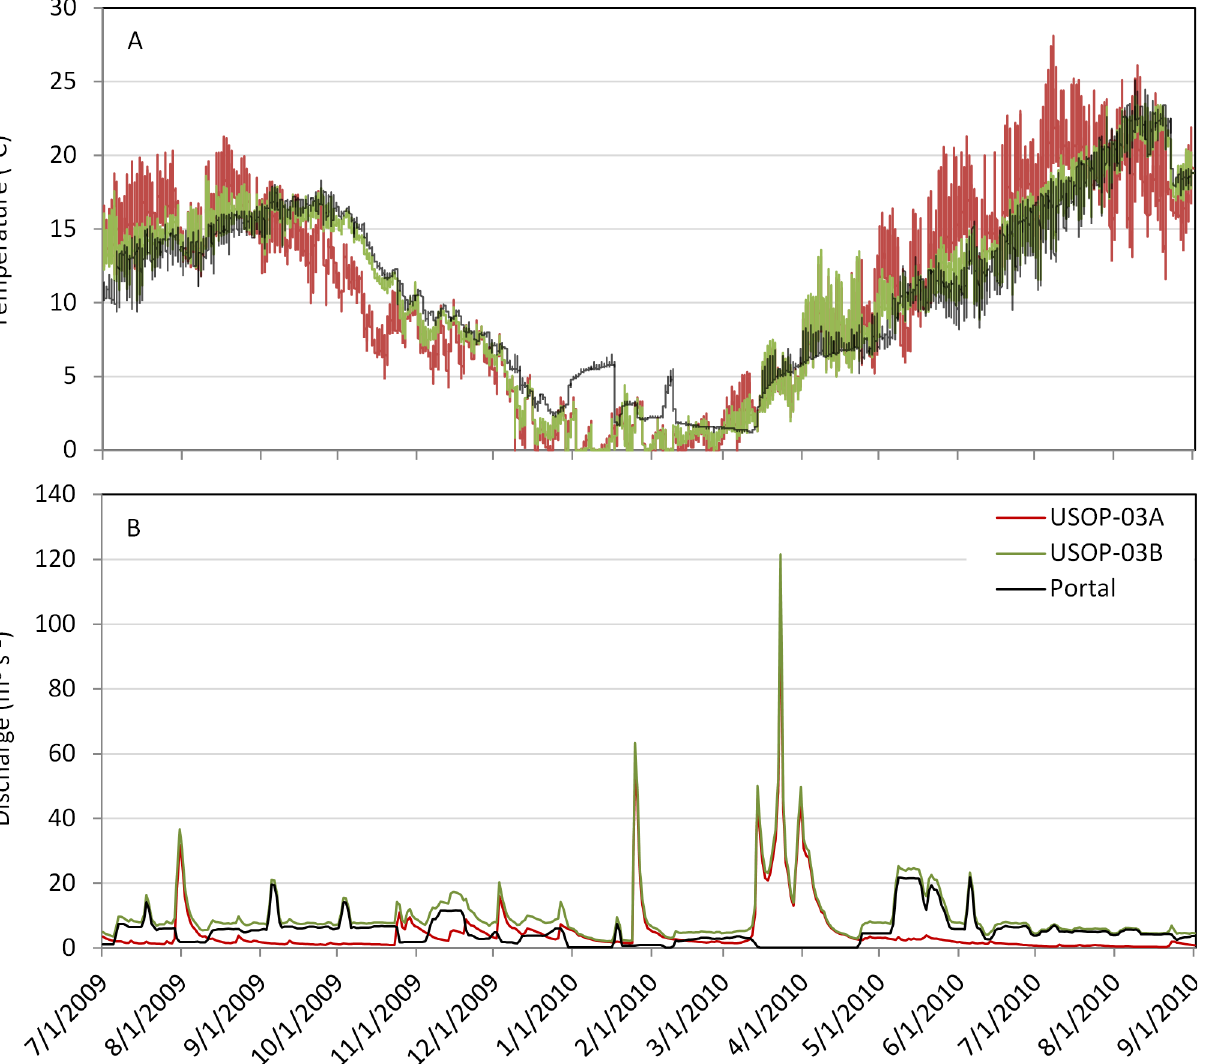
Fig 6. Continuous (15-minute) water temperature (A) and daily discharge (B) at USOP-03A (red), USOP-03B (green), and the Shandaken Portal (black) for the period 7/1/2009 –